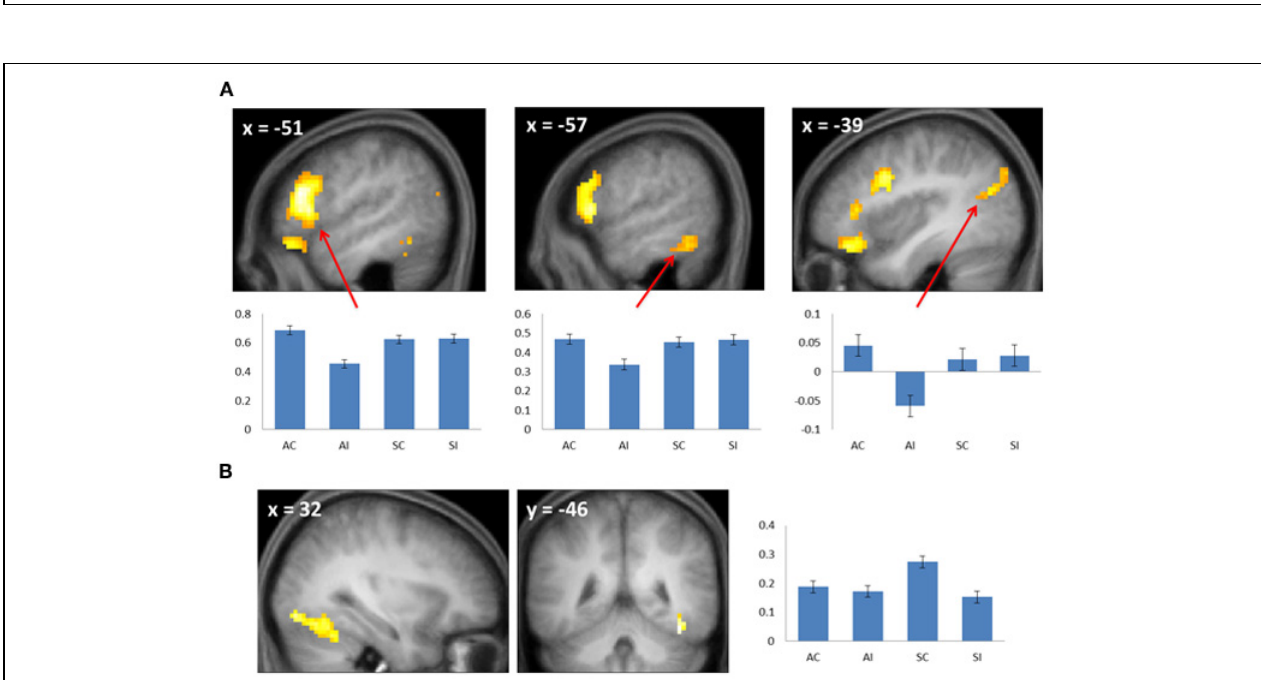
FIGURE 2 | Common subsequent memory effects. Bar plots show mean parameter estimates (left to right) for the four conditions of interest (AC, associative correct; AI, associative incorrect; SC, source correct; SI, source incorrect) for peak voxels in the left fusiform (left), left anterior hippocampus/amygdala (center), and left putamen (right). Results are overlaid onto sections of the across-subjects mean